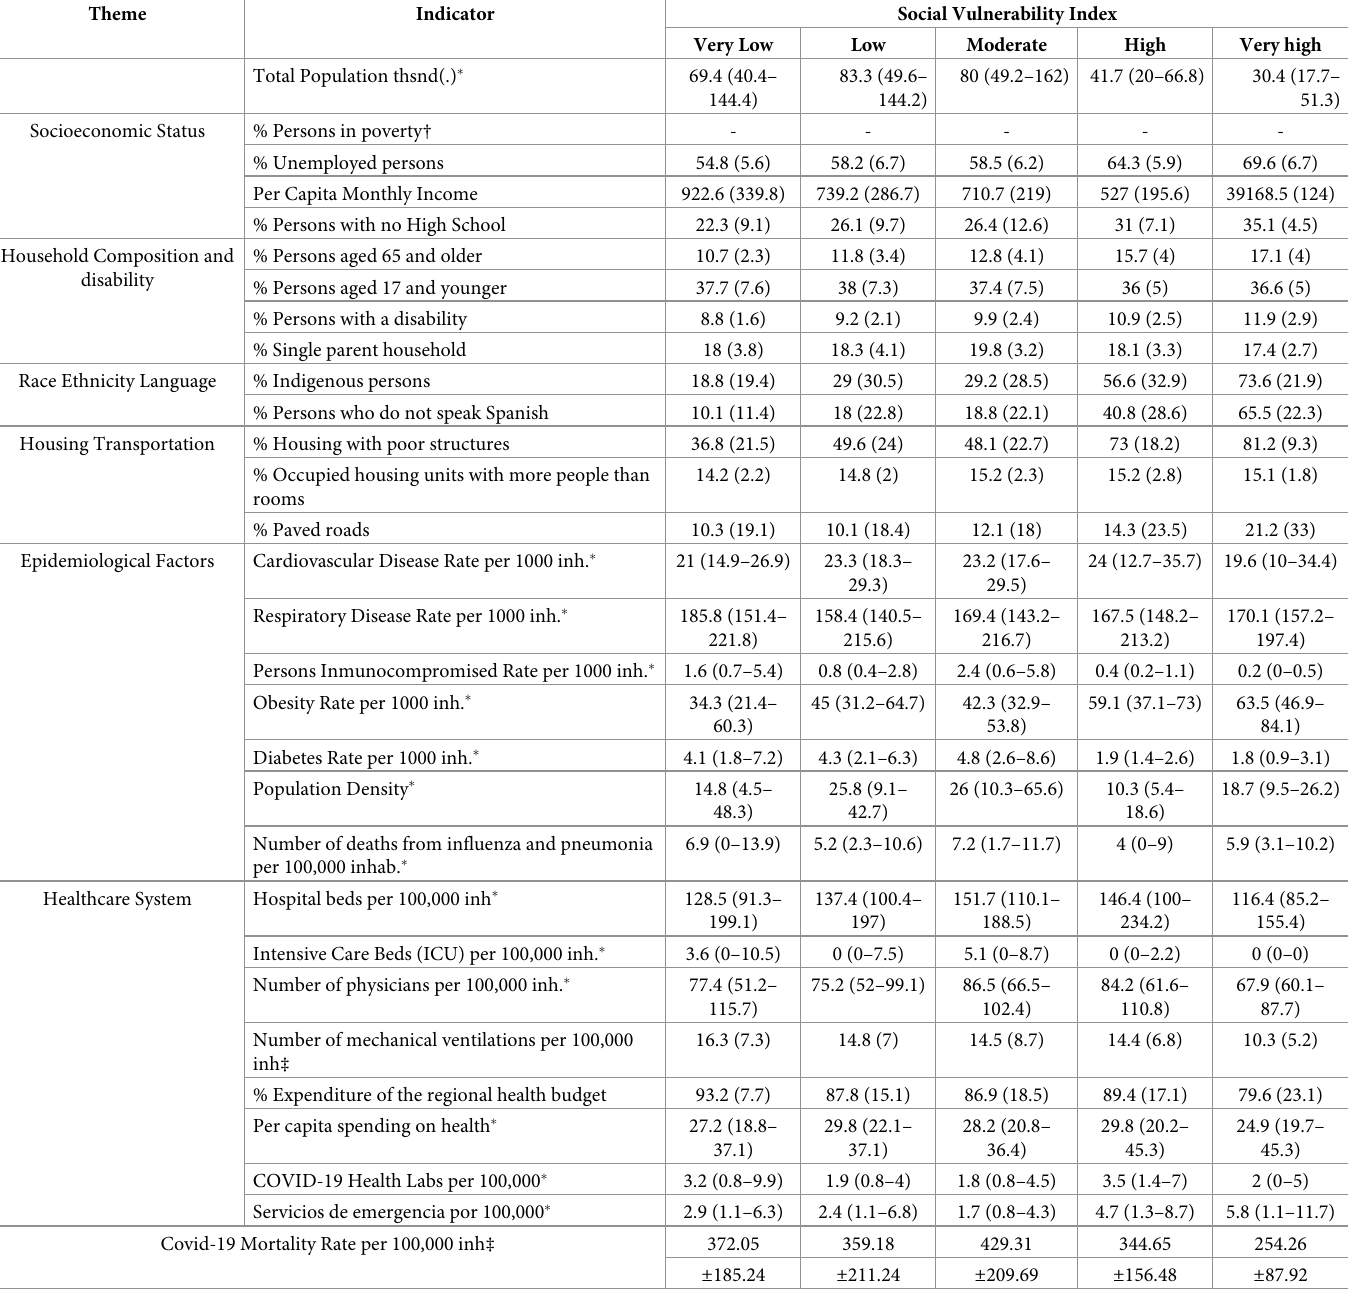
Table 1. Descriptive statistics for Peru provinces vulnerability indicators (n =